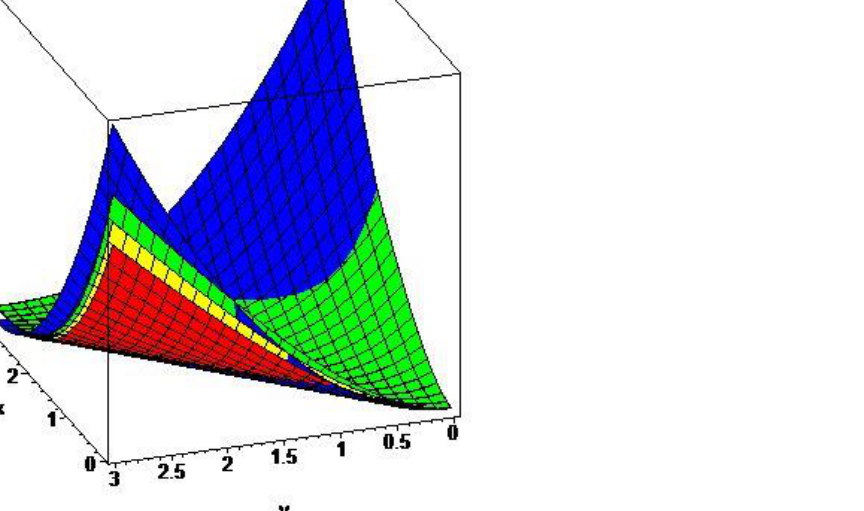
( ϕ ) to ϕ (blue) on [ 0,3 ] × [ 0,3 ] for β 75,75